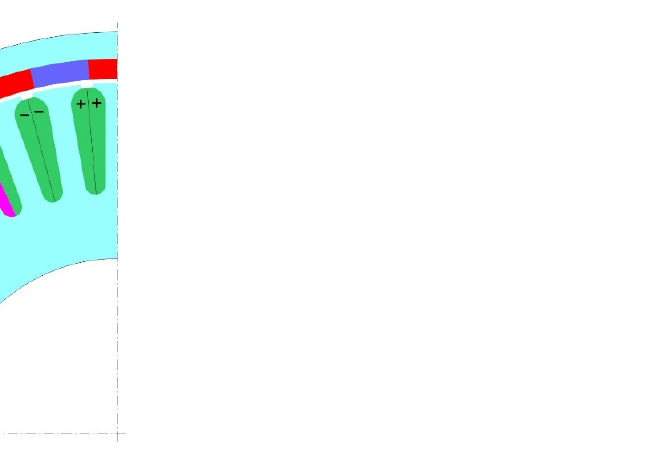
Figure 12. Fragment of a cross-section of a 3-phase FSCW-PMSM machine with 40 poles and 36 teeth-coils.